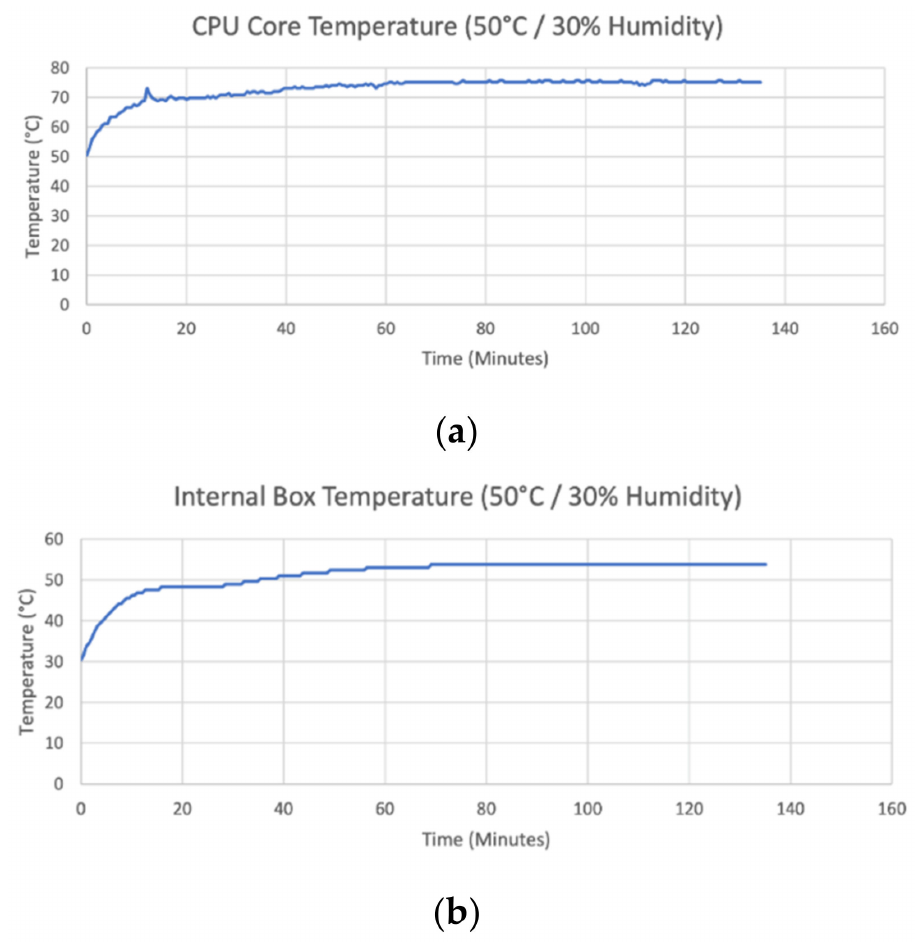
Figure 9. Experiment 3 results from environmental chamber testing of the camera trap. ( a ) CPU temperature with environmental chamber at 50 ◦ C and 30% humidity. ( b ) Internal box temperature with environmental chamber at 50 ◦ C and 30%